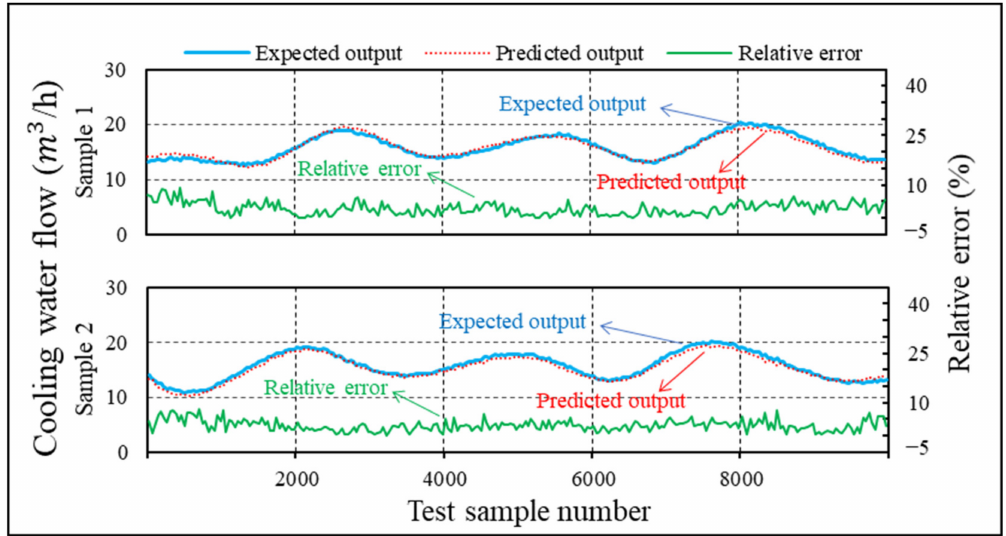
Figure 7. Predicted cooling water flow by